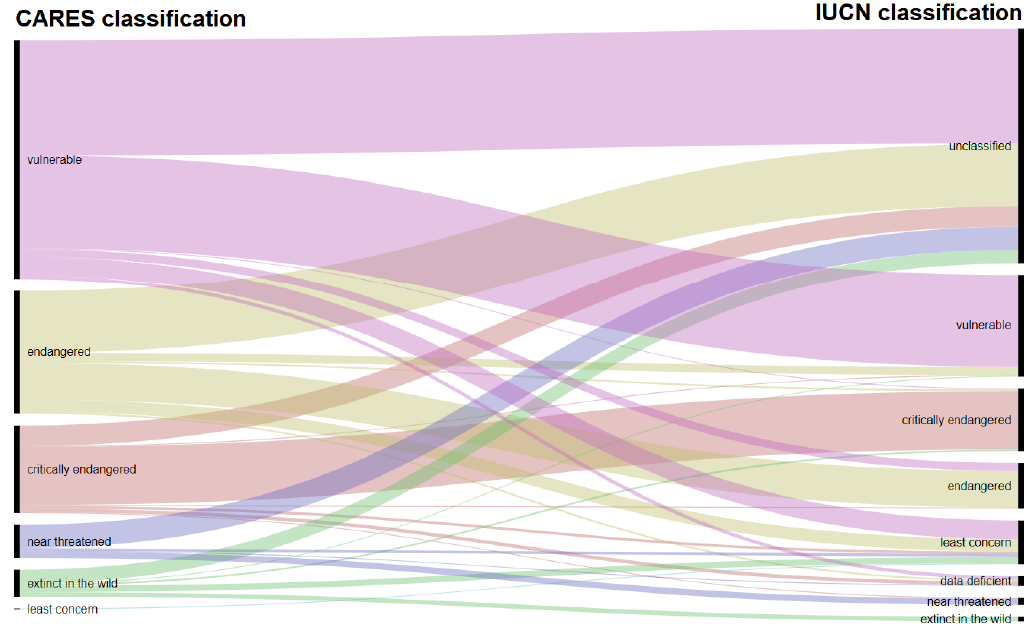
Figure 1. Classification of CARES species found in the IUCN. http: // app.rawgraphs.io / .